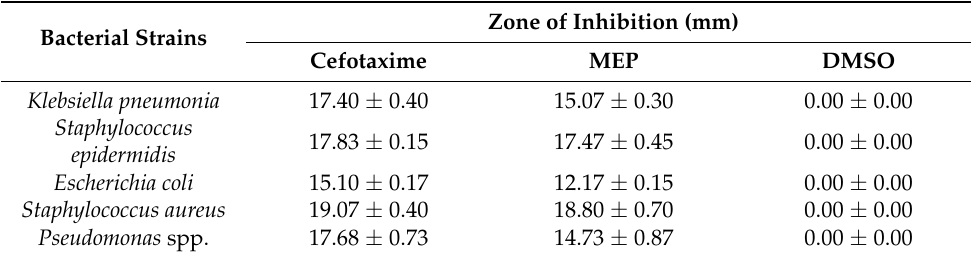
Table 3. Zone of inhibition against different bacterial